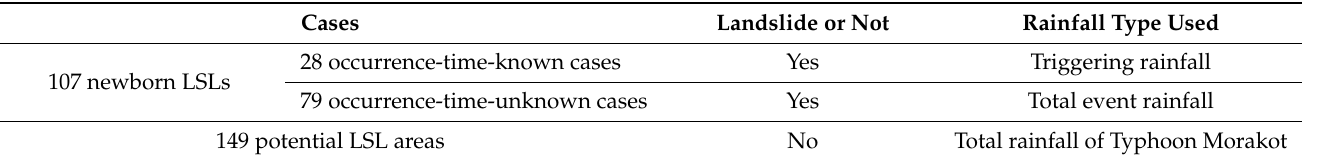
Table 3. Information of selected